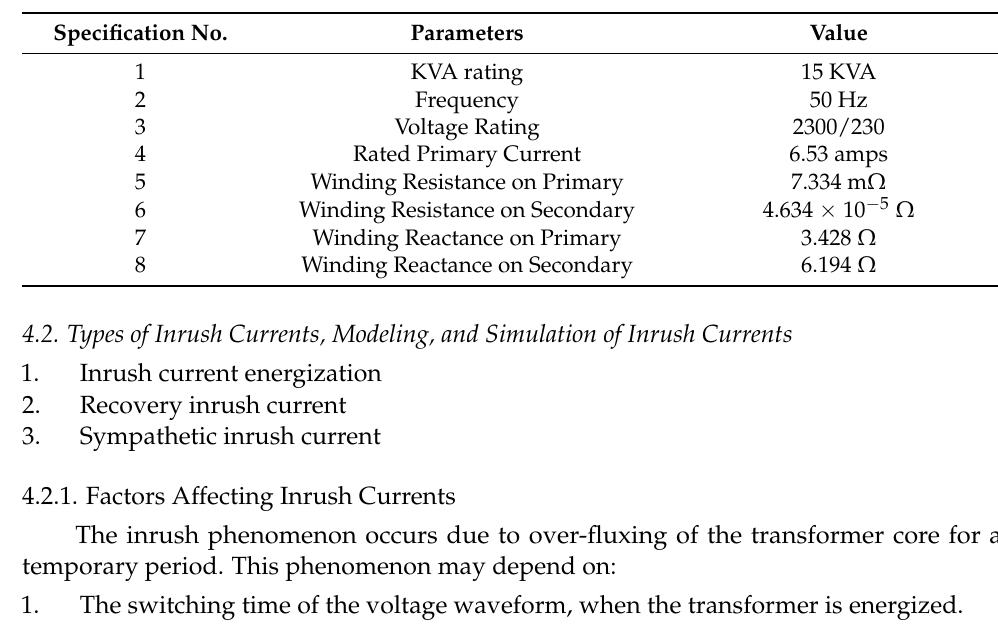
Figure 4. Transformer equivalent circuit under the no-load condition.